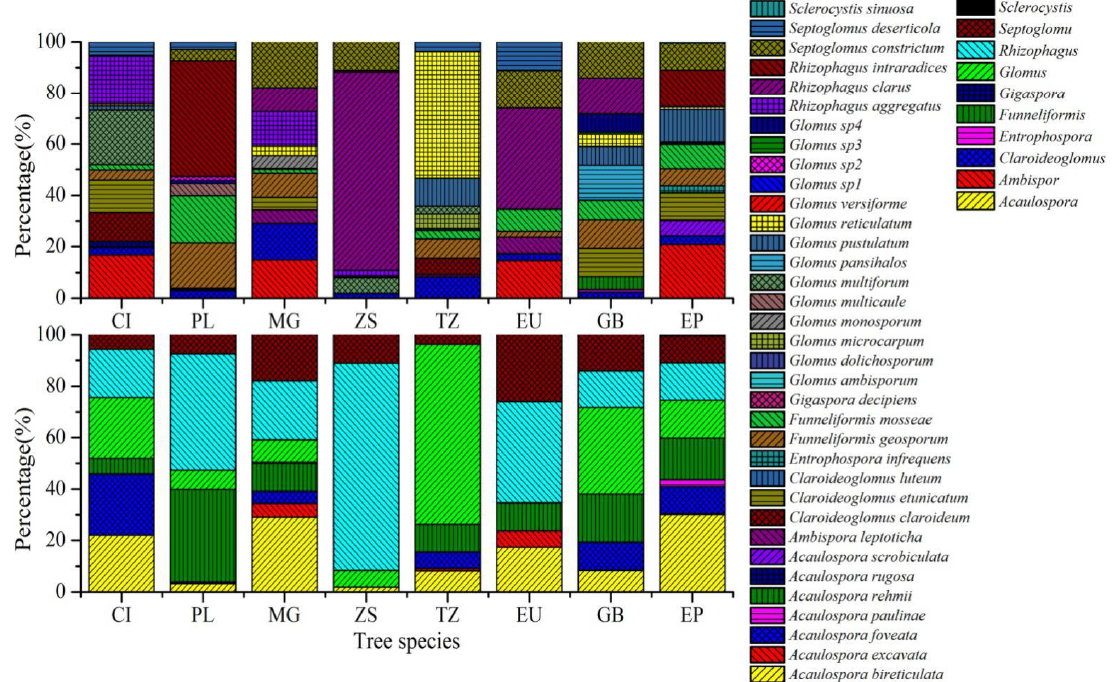
Figure 1. AMF community composition in the rhizosphere soils of different tree species. Tree species: CI, Carya illinoensis ; PL, Populus lasiocarpa ; MG, Metasequoia glyptostroboides ; ZS, Zelkova serrata ; TZ, Taxodium ‘zhongshansha’ ; GB, Ginkgo biloba ; EP, Elaeagnus pungens.